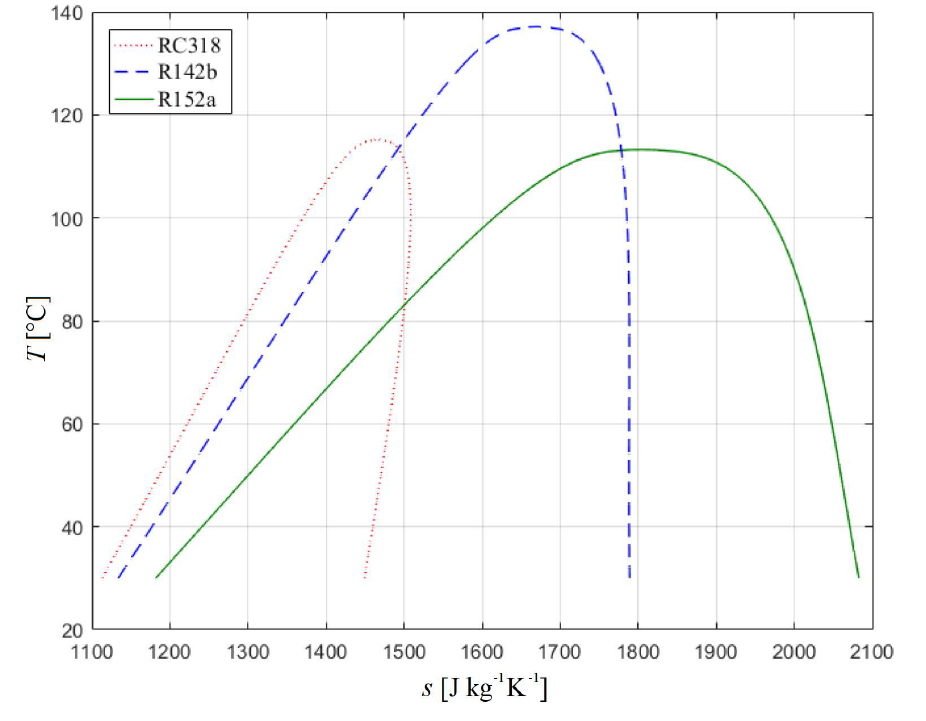
Figure 3. Vapor saturation line of a dry (RC318), an isentropic (R142b), and a wet fluid